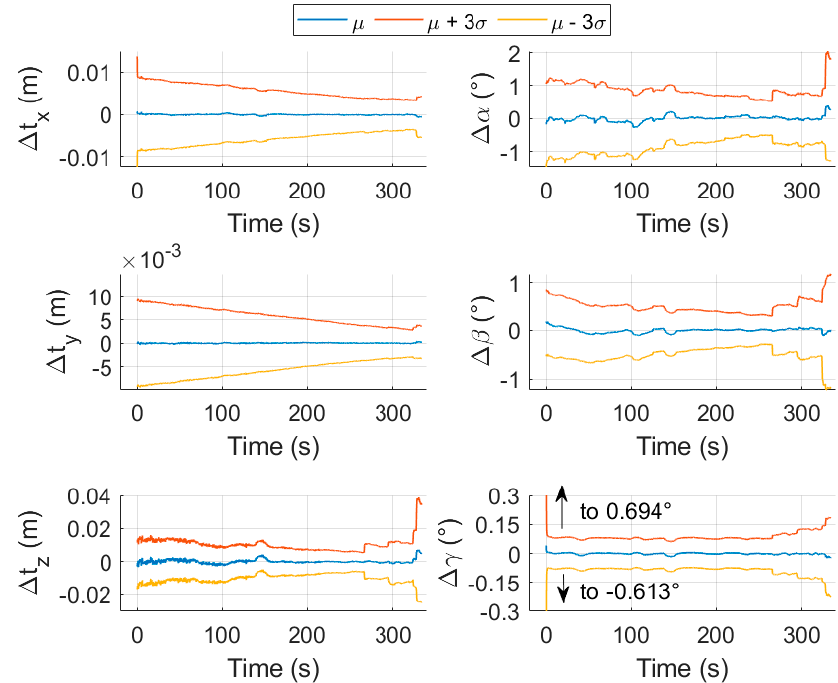
Figure 19. Temporal evolution of the mean of the errors on the pose parameters, with representation of the 3 σ intervals, for test M1. The plots are focused on intervals about the mean values: the arrows indicate the maximum values reached by the pose initial guess at scenario start.